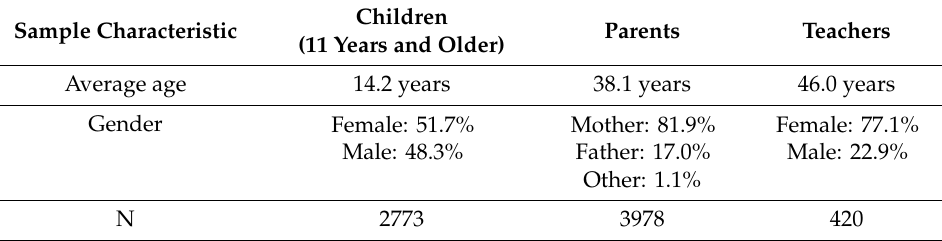
Table 2. Sample characteristics (children, parents and teachers, T0 measurement, 2017).